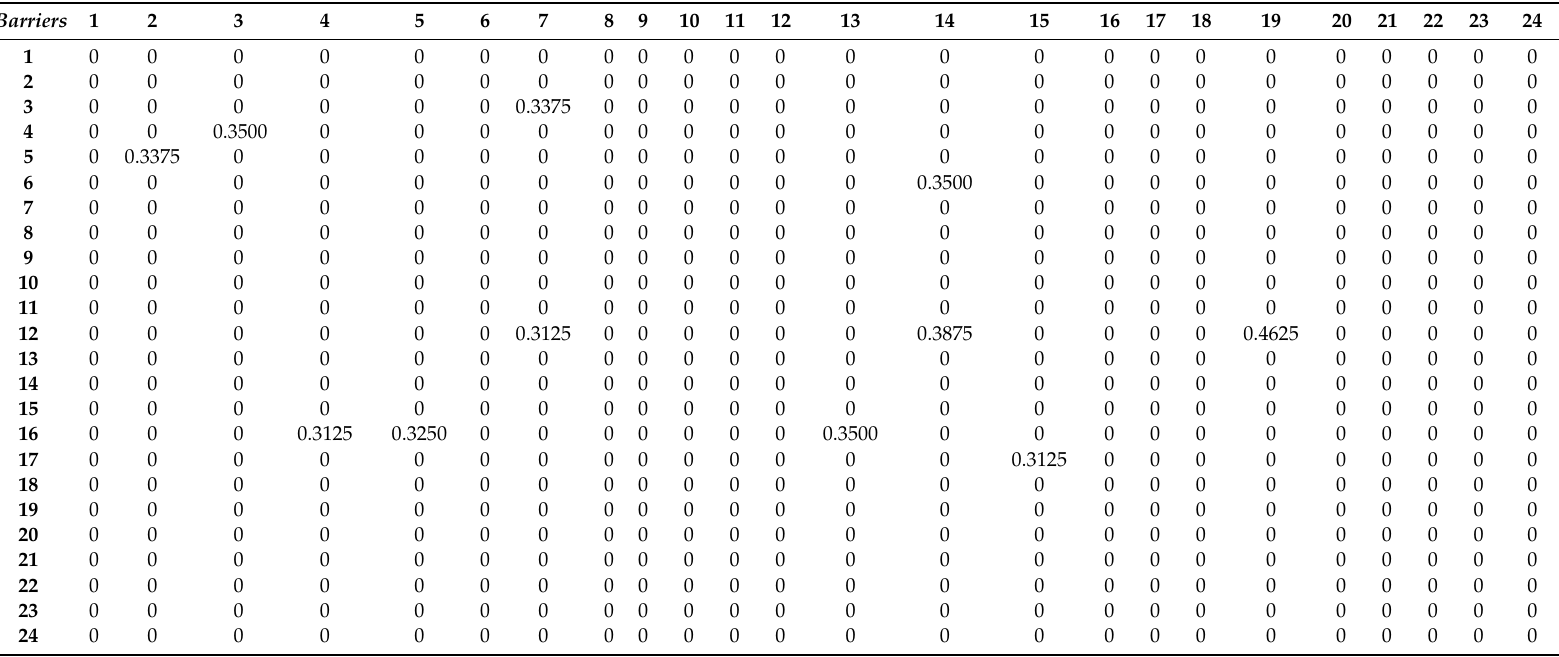
Table 3. Final FCM